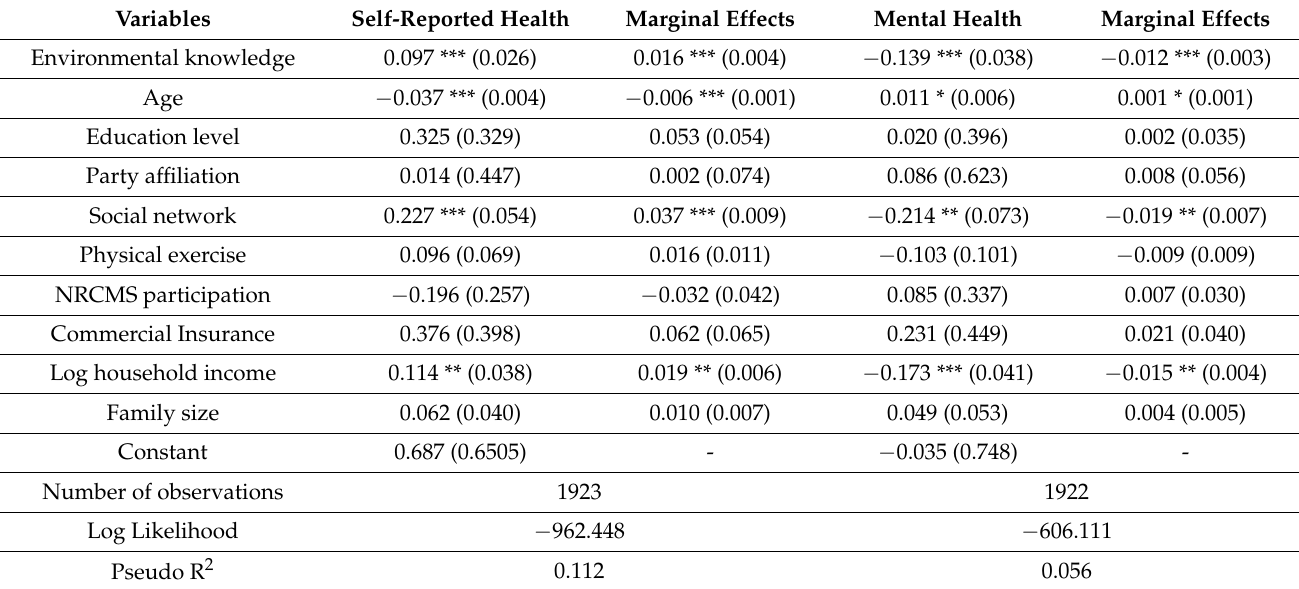
Table 2. The results of the basic logit regression